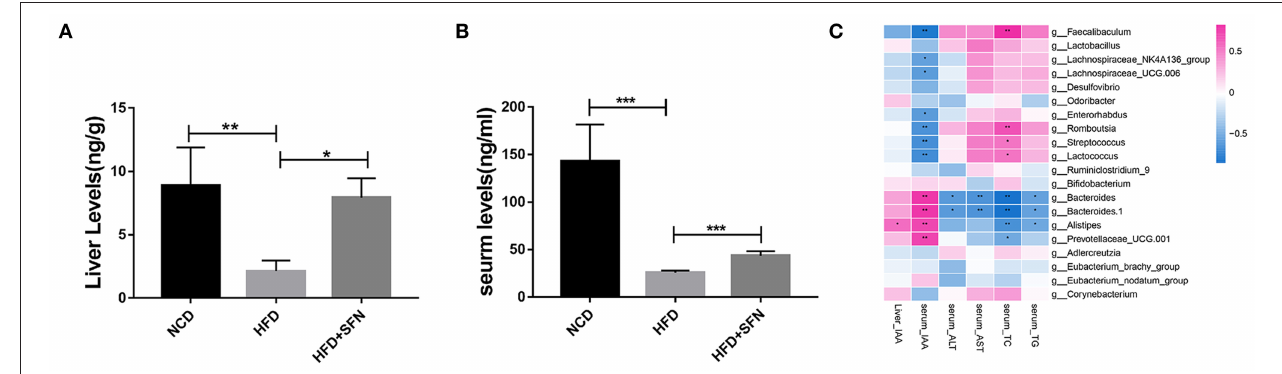
FIGURE 5 | IAA concentrations in the liver (A) and serum (B) from mice of different groups. (C) Heatmap of the Spearman r correlations between the gut microbial species and biomarkers. Data are presented as mean ± SD. * P < 0.05, ** P < 0.01, *** P < 0.001 vs. HFD